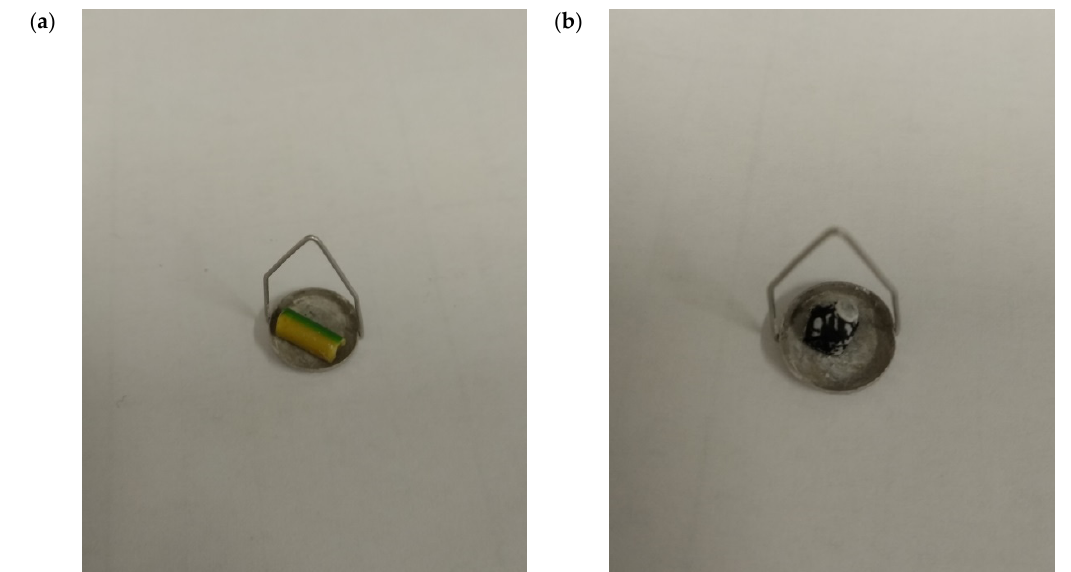
Figure 17. Insulation of a PVC coaxial cable placed in the TGA test platinum pan: ( a ) before the test, ( b ) after the test.